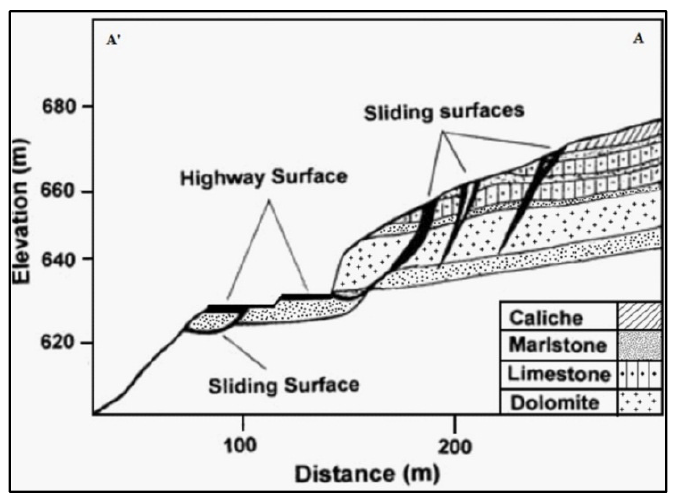
Figure 3. Schematic geologic cross section of the landslide ([71,77]).